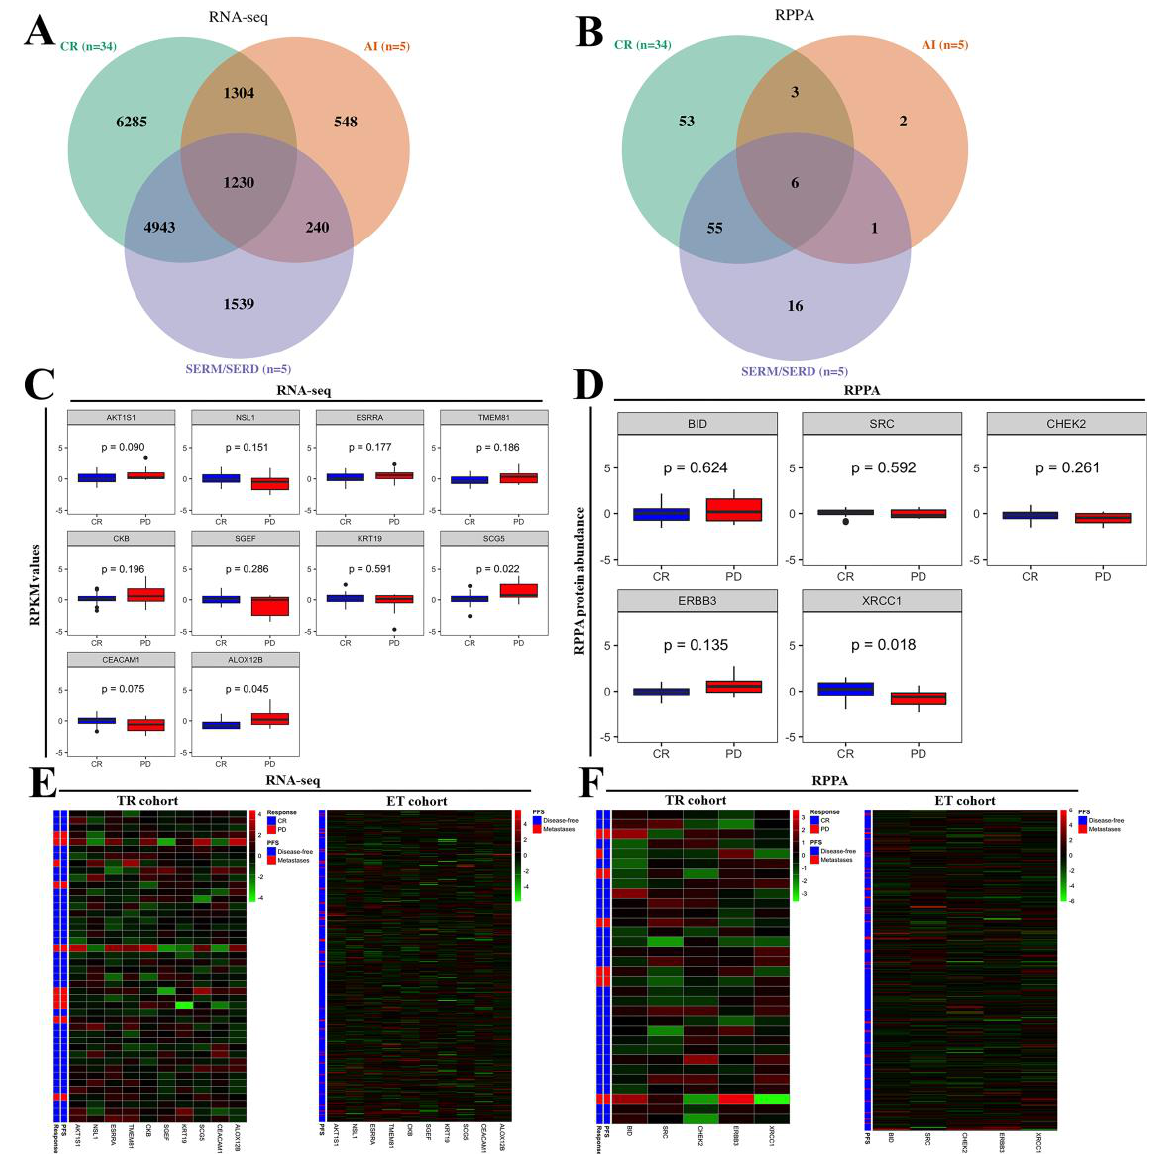
Figure 2. The candidate gene set of RNA − seq and RPPA in both SERM/SERD and AI of ET resistance. ( A , B ) The Venn diagram analysis shows that there are 1470 targets of RNA − seq and seven targets of RPPA in both SERM/SERD and AI of ET resistance. ( C – F ) Based on a series of analyses and selection, the expression of candidate gene sets from RNA − seq of ten targets and RPPA of five targets is displayed as box plots in the treatment response cohort (TR cohort) and heatmap in the treatment response (TR cohort) and endocrine therapy cohort (ET cohort). Table 4. The results of optimal cut-off point and individual ROC analysis in 29 targets from